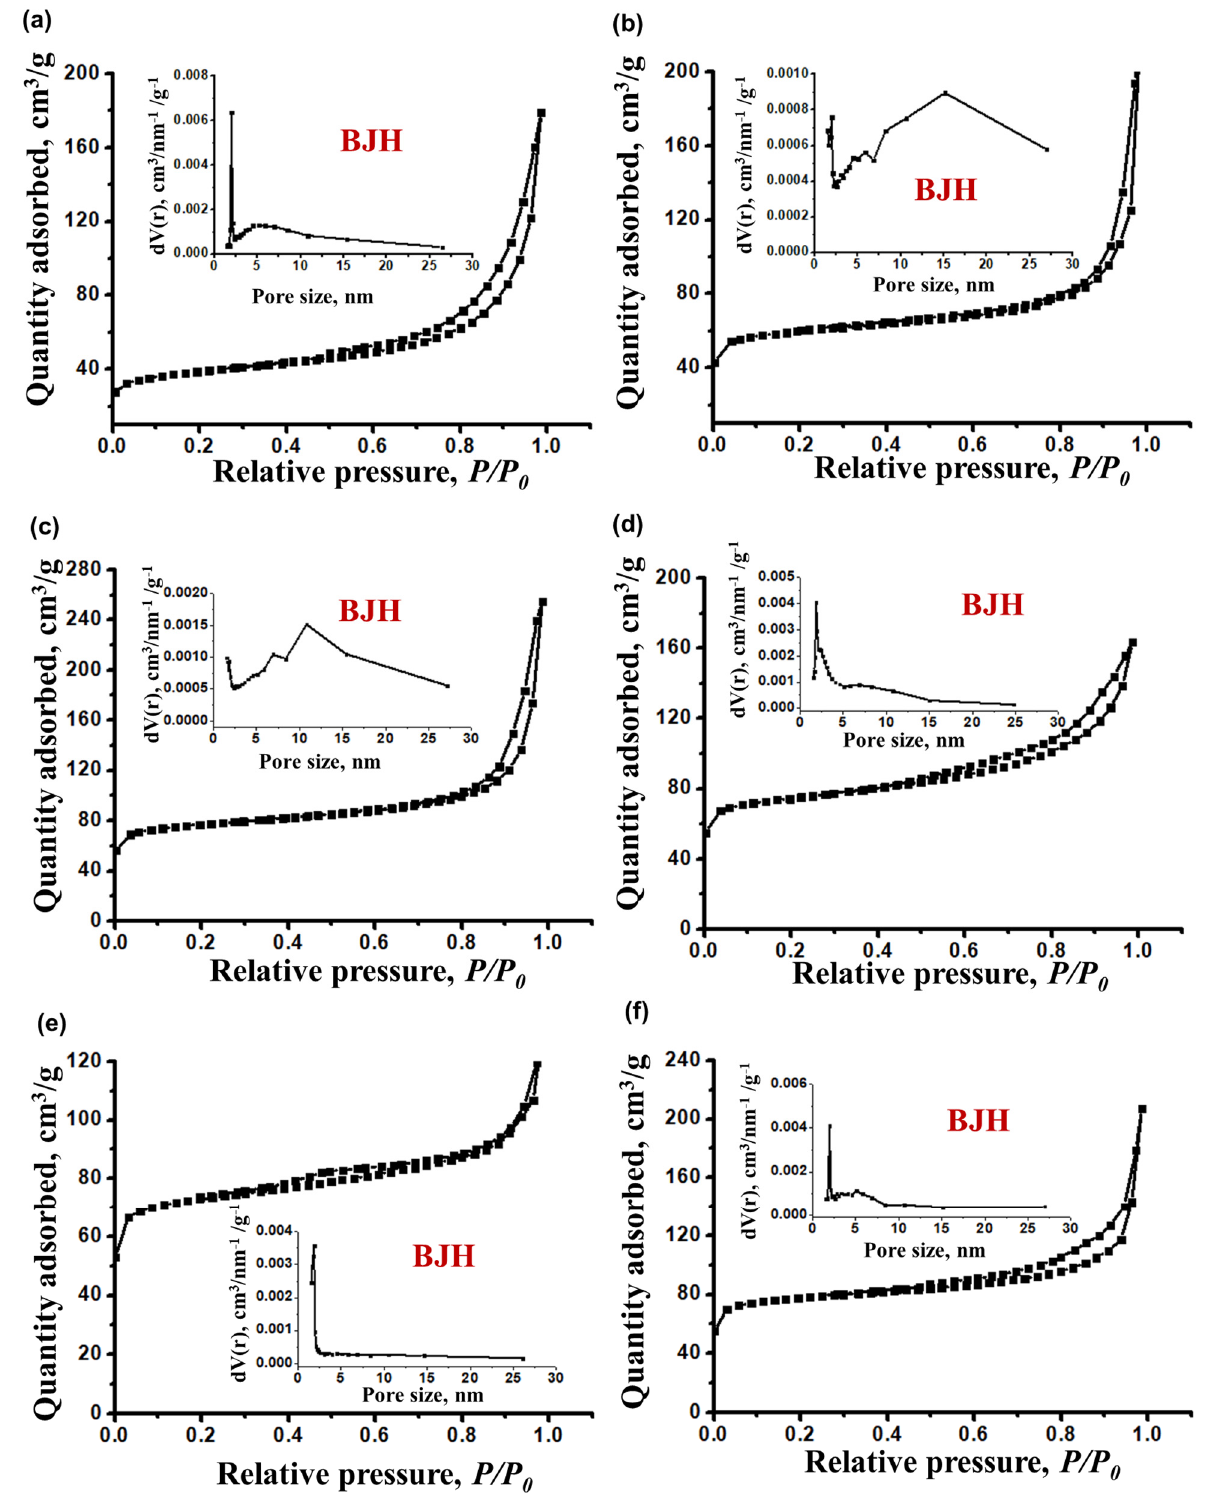
Figure 11. Nitrogen adsorption-desorption isotherms and pore size distribution of silicoaluminophosphate molecular sieves: ( a ) Sample SAPO-11TR(60); ( b ) Sample SAPO-11TR(90); ( c ) Sample SAPO-11SB(90); ( d ) Sample SAPO-11SB(120); ( e ) Sample SAPO-11RP(90); ( f ) Sample SAPO-11RP(120).